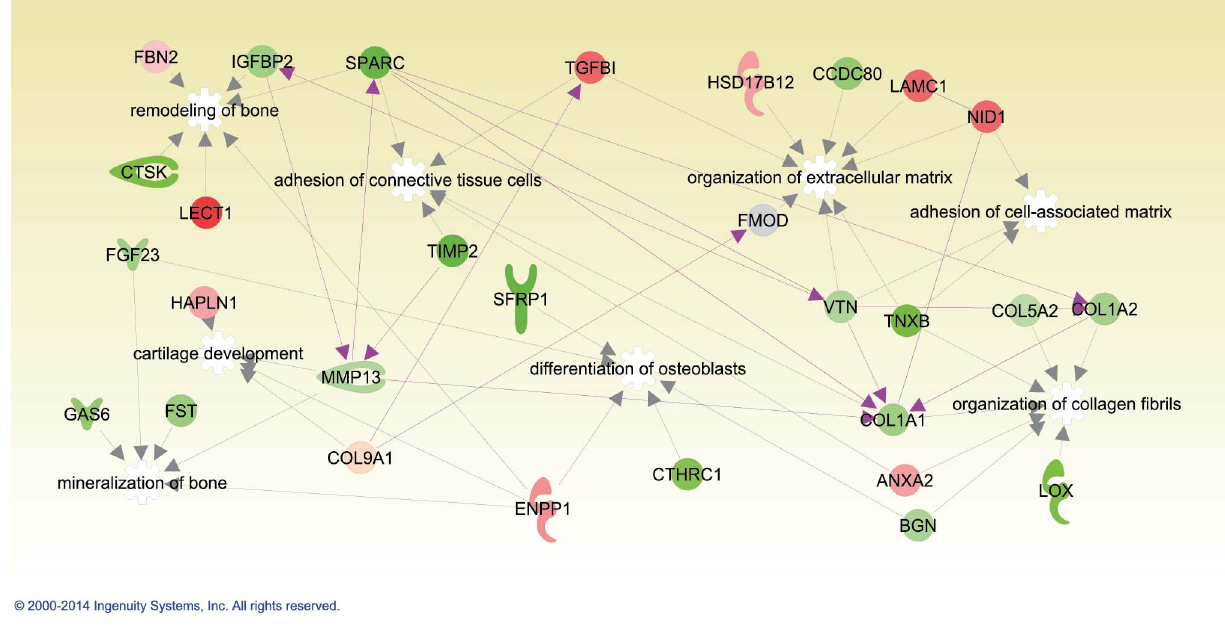
Figure 5. Ingenuity Pathway Analysis (IPA). Proteins that differ in abundance are involved in connective tissue, skeletal and muscular development. Green shading indicates an increase in abundance during development whereas red shading indicates a decrease. Increased intensity in colors indicates a higher differential abundance. doi:10.1371/journal.pone.0090568.g005 PLOS ONE |